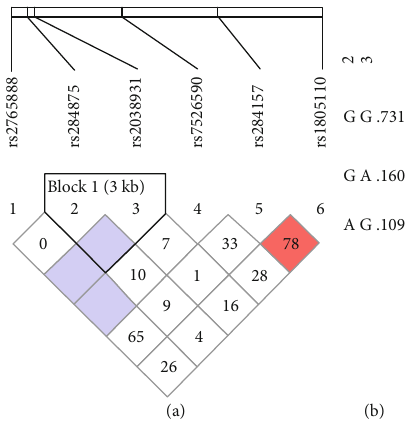
Figure 1: Linkage disequilibrium analysis of rs2765888 ( C > T ), rs284875 ( A > G ), rs2038931 ( G > A ), rs7526590 ( A > T ), rs284157 ( C > T ), and rs1805110 ( G > A ) using the four-gamete rule method. (a) According to HaploView 4.2 color schemes, white corresponds to D ’ < 1 and LOD < 2 , shades of pink/red indicate D ’ < 1 and LOD ≥ 2 , and light blue indicates complete LD with D ’ = 1 and LOD < 2 . (b) Identi fi ed haplotypes and associated frequencies. LOD: Log of odds ratio, a measure of con fi dence of the value of D ’ .